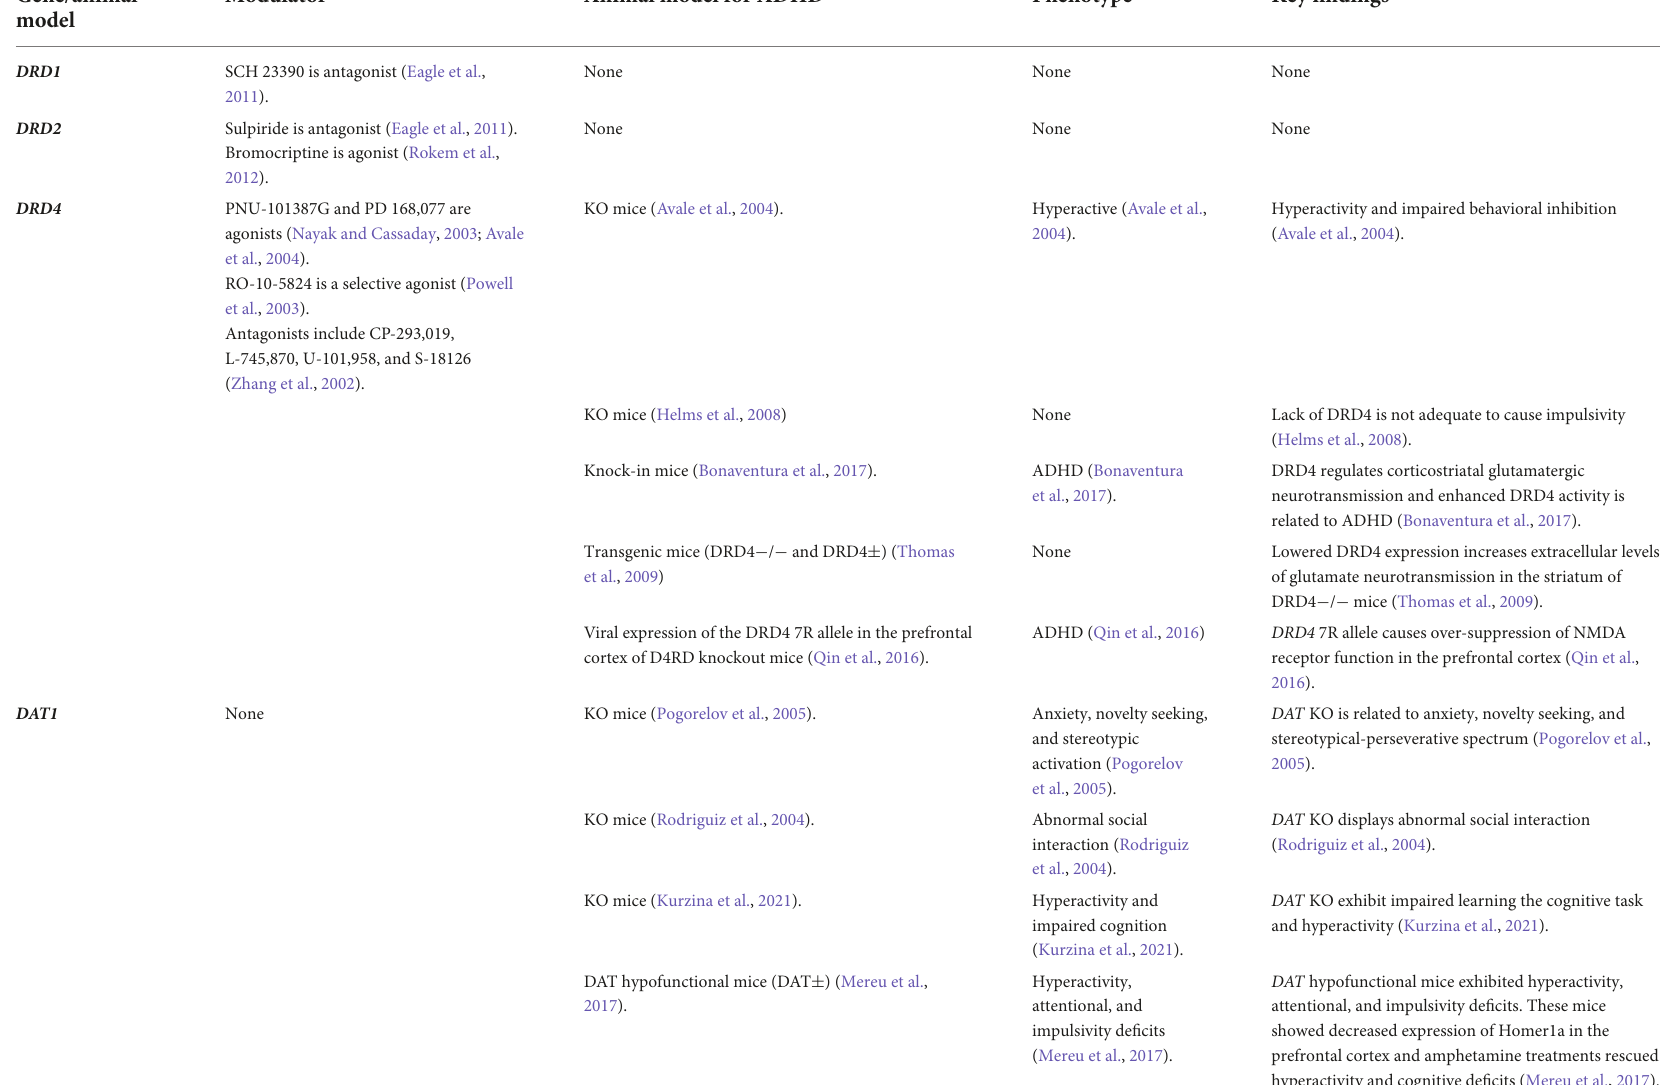
TABLE 2 Genes related to ADHD in animal models and